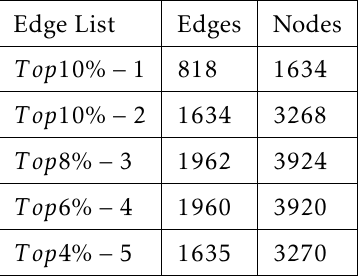
Table 2. Edge Lists for Each Centrality Measure (i.e., indegree, outdegree, Betweeness, Closeness and PageRank) Edge List